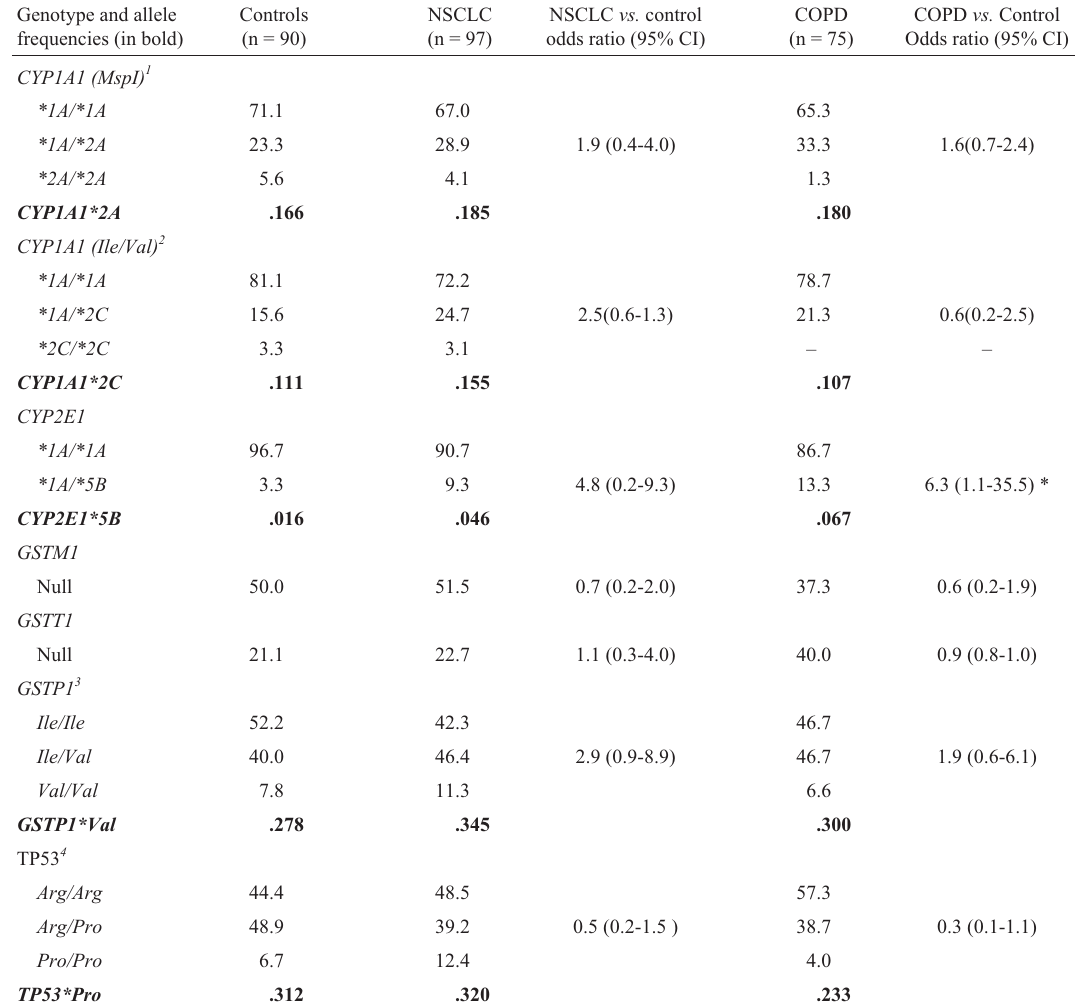
Table 3 - Allele frequencies (%) of cytochrome P ( CYP1A1 , CYP2E1 ), glutathione-S-transferase ( GSTM1 , GSTT1 and GSTP1 ) and tumor suppressor ( TP53 ) genotypes in patients with non-small-cell lung cancer (NSCLC) or chronic obstructive pulmonary disease (COPD). Genotype and allele frequencies (in